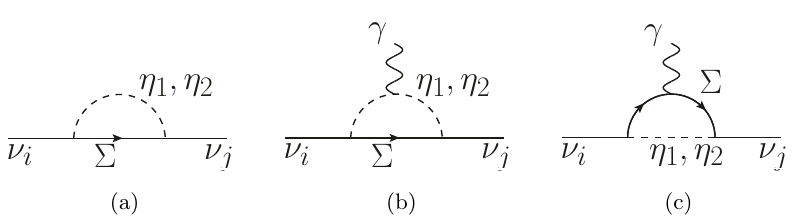
Figure 5 . Diagrams for neutrino mass and magnetic moment in the radiative neutrino mass